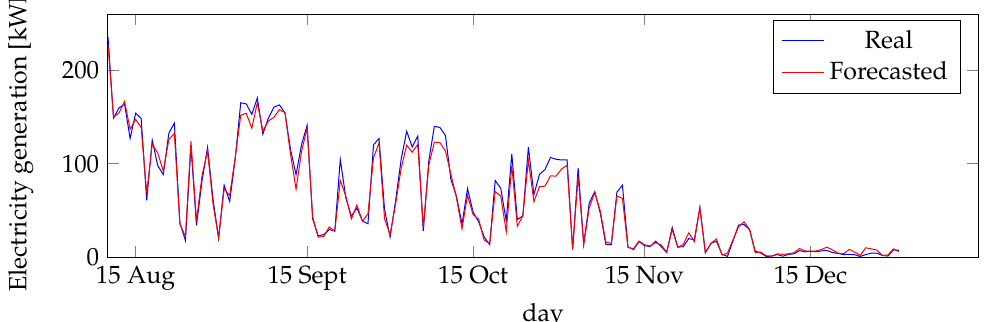
Figure 10. Forecasting results for 10 August to 31 December 2021 using